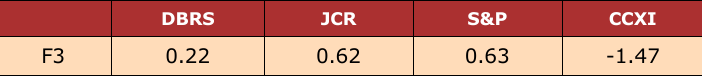
Table 9. The Assessment Value of Technology